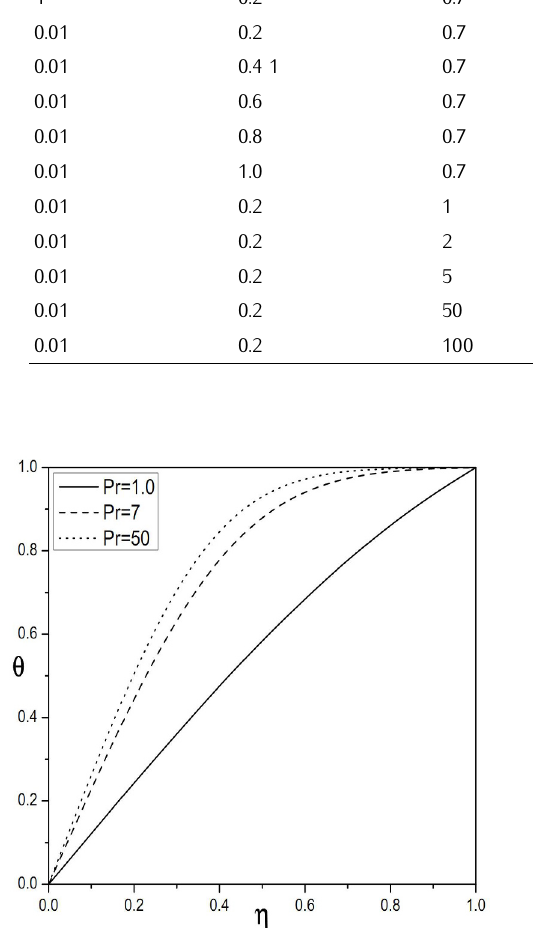
Figure 9. Heattransferrateonthewallsfordifferentvaluesof Pr & S